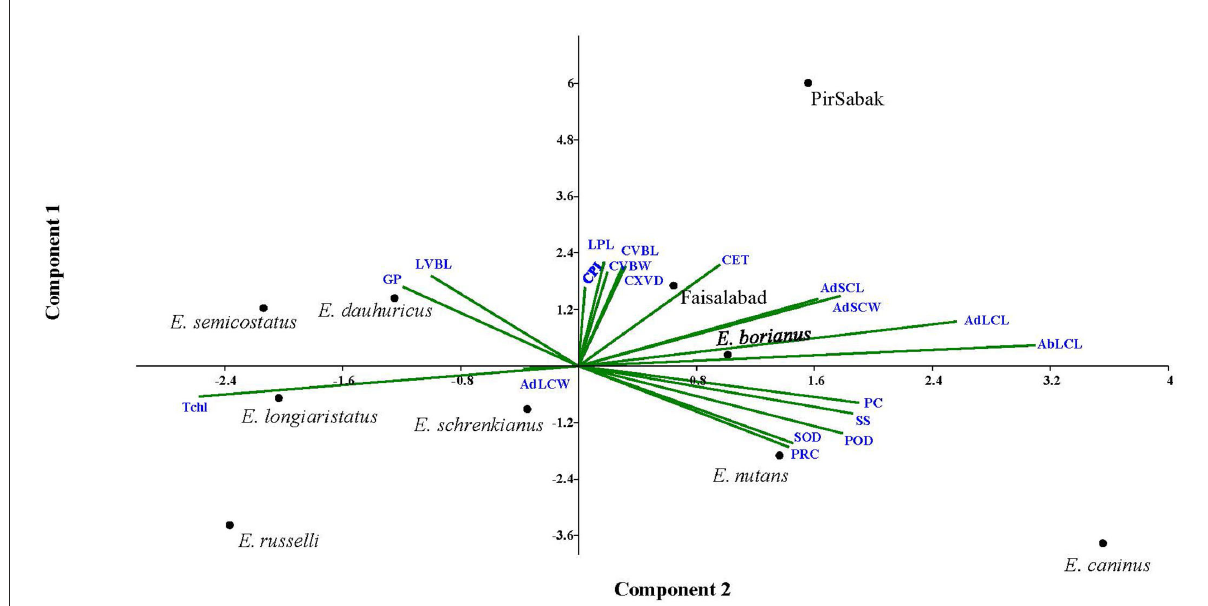
FIGURE5 Principal component analysis (PCA) of the studied traits in Elymus species and wheat cultivars. Trait vectors exhibiting angles ≤ 90 ◦ have a positive relationship, while those with angles depict negative associations ≥ 90 ◦ . PCA revealed up to 62.8% of the variability being explained by the first two